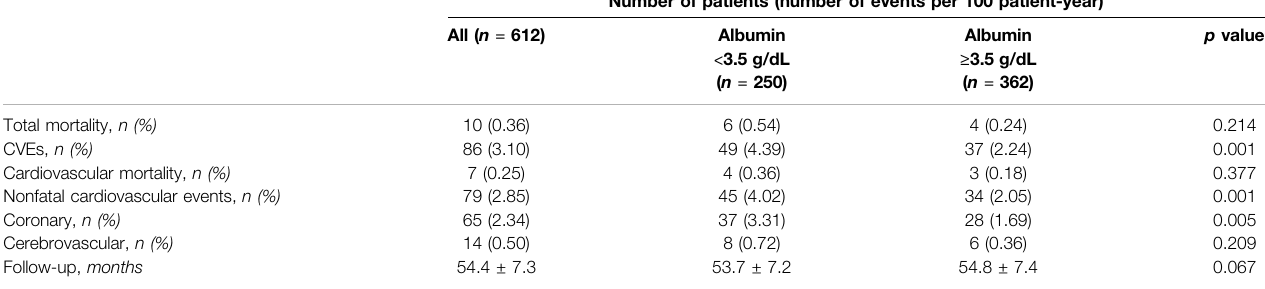
Number of patients (number of events per 100 patient-year)